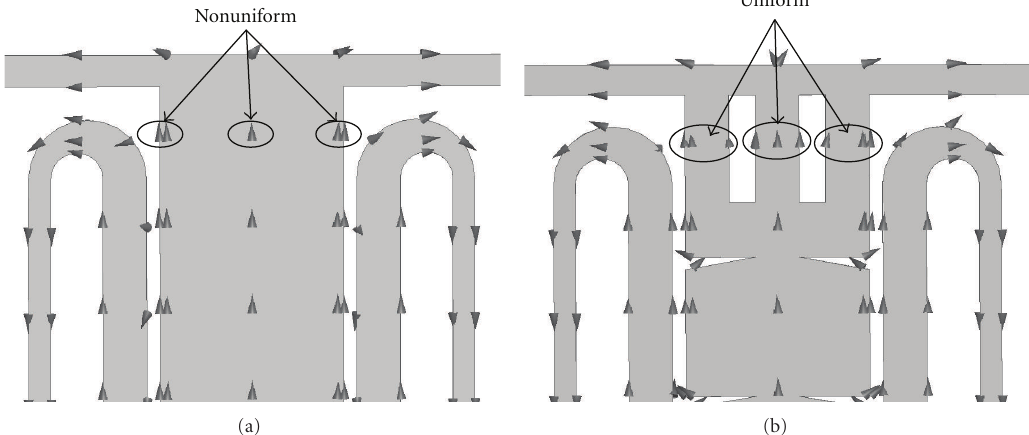
Figure 3: (a) A common CPW feeding line (b) A CPW feeding line with a trident-shaped feeding strip and triangular slot stubs.